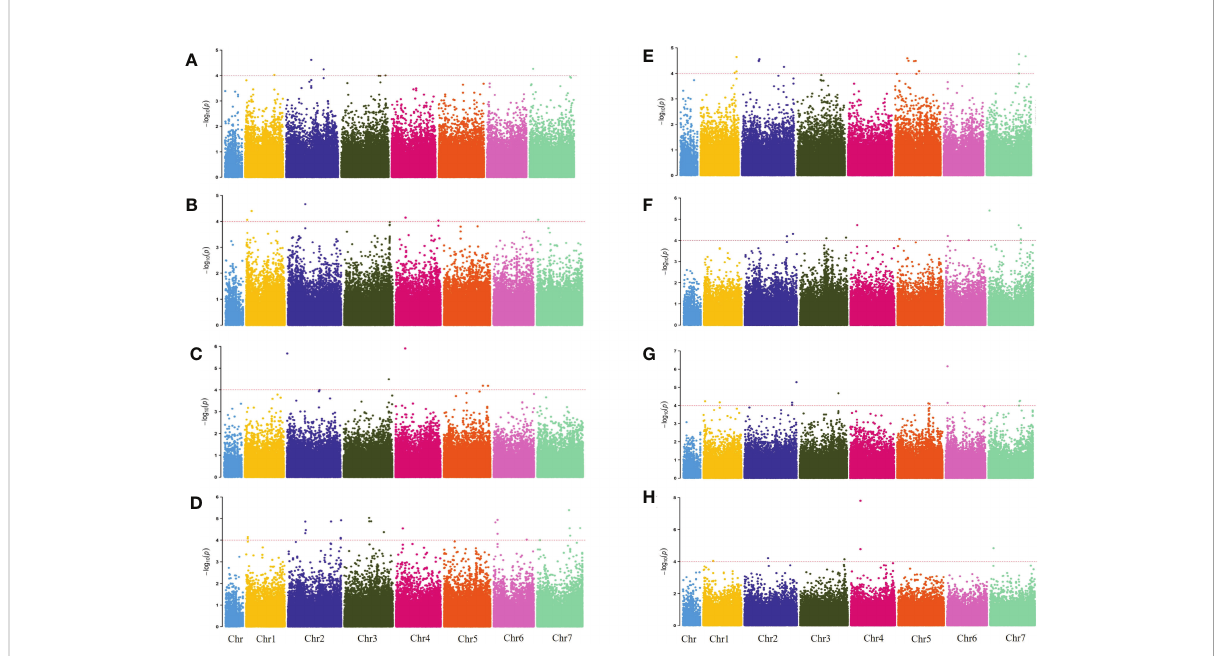
FIGURE 2 Manhattan plots for 2019 WLS-1, 2019 Q34 WLS-2, 2019 WLS-3, 2019 WLS-4, 2020 WLS-1, 2020 WLS-2, 2020 WLS-3, 2020 WLS-4 were shown in (A – H) , respectively. The x-axis shows SNP loci along the seven barley chromosomes. The horizontal red line shows the genome-wide signi fi cance threshold P-value of – log10 (P-value) value of 4.0. GWAS was performed using the MLM (Q + K)